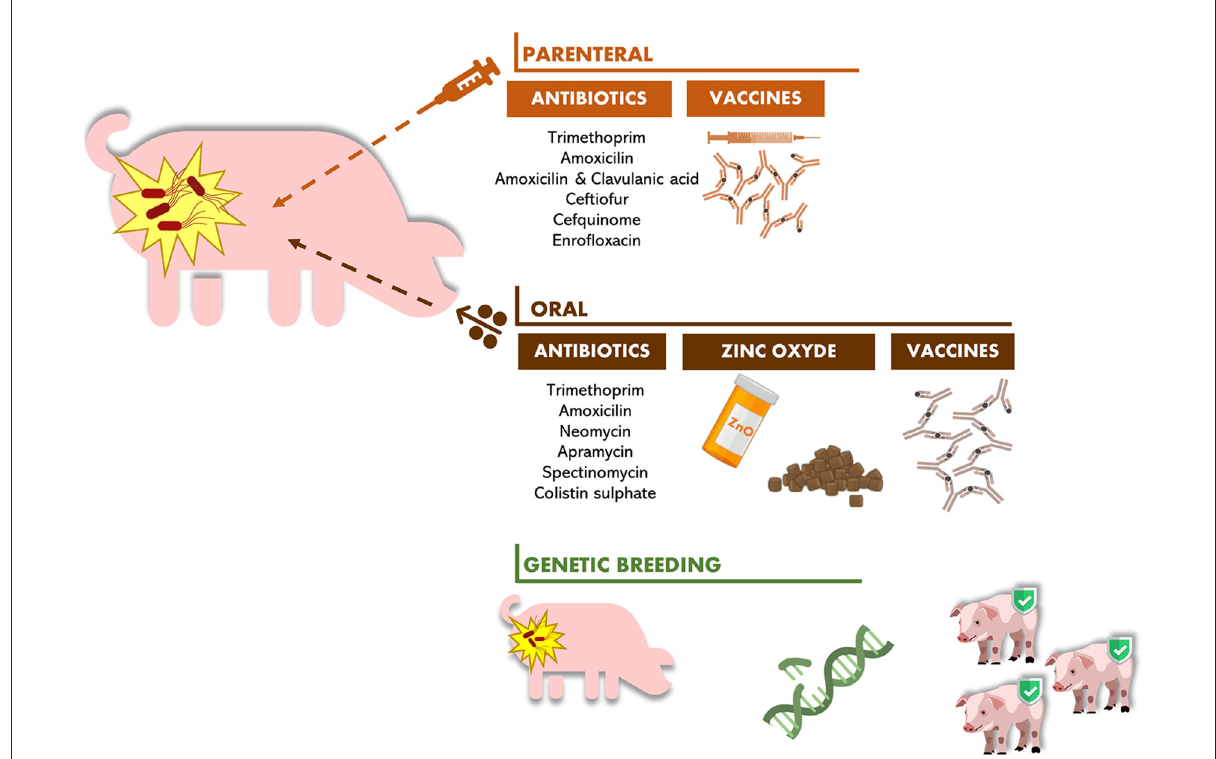
FIGURE1 Current therapies used to control PWD in